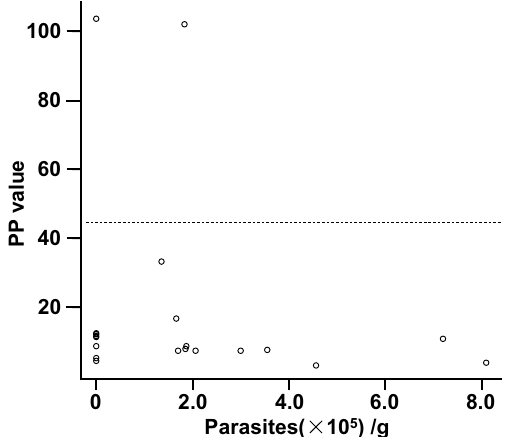
Figure 3. Cross-reactivity of antibodies induced by Sarcocystis infection was negligible when using ELISA kit designed for anti- T. gondii antibodies. Correlation between the number of bradyzoites in the diaphragm and the PP values of the commercial ELISA system used in this study. Each dot represents data from each wild boar. The dotted line indicates the cut-off line of the ELISA